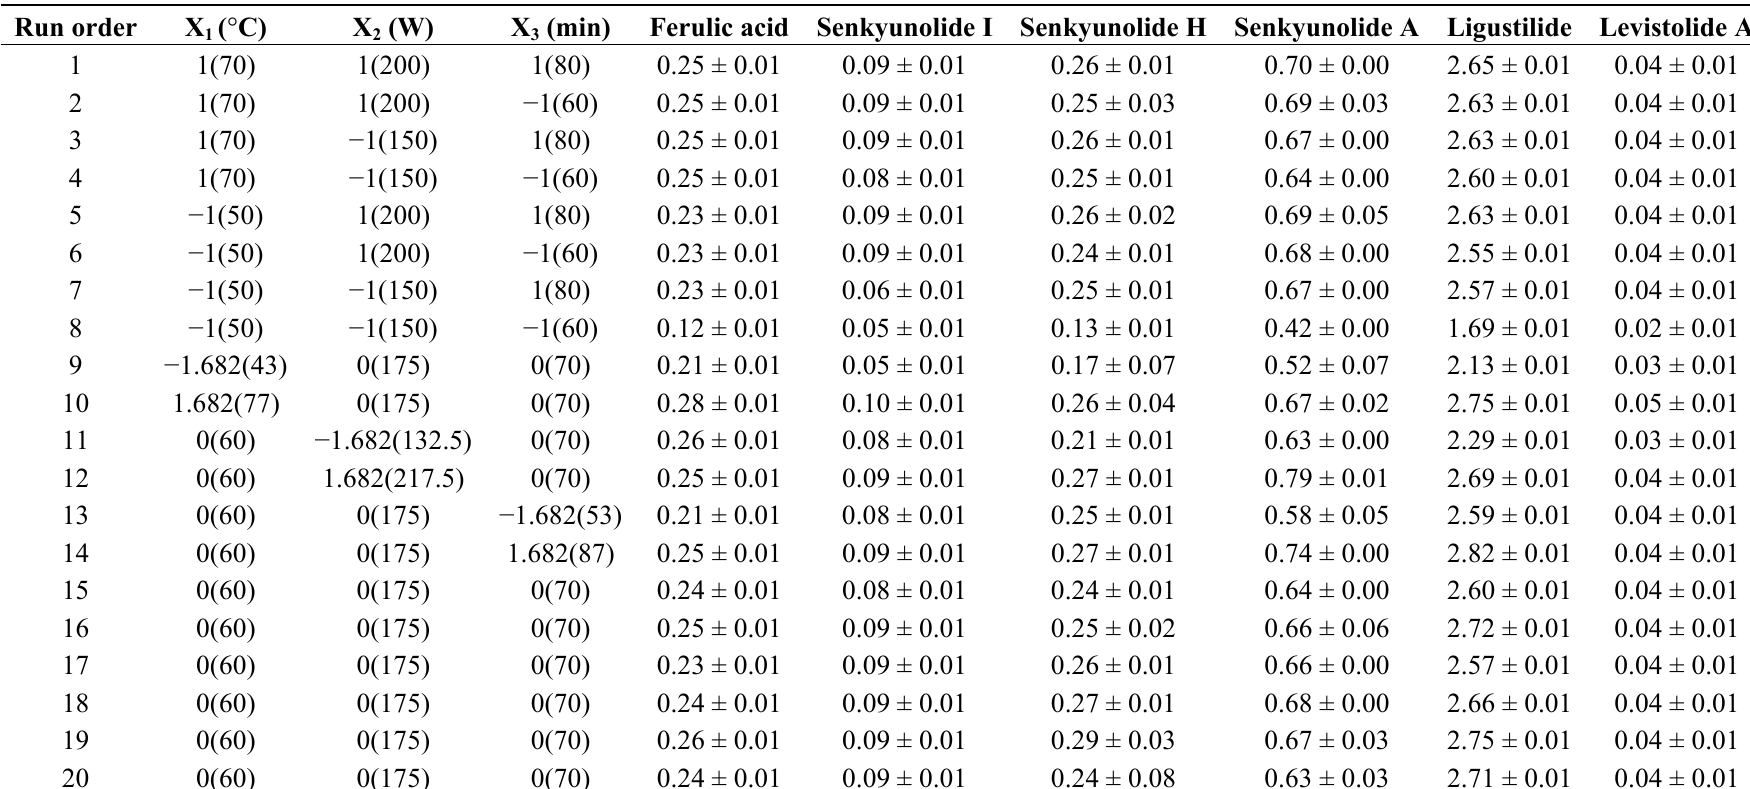
Table 2. Extraction yield of response surface CCD ( n = 3) and expressed as mean ± SD (Units: